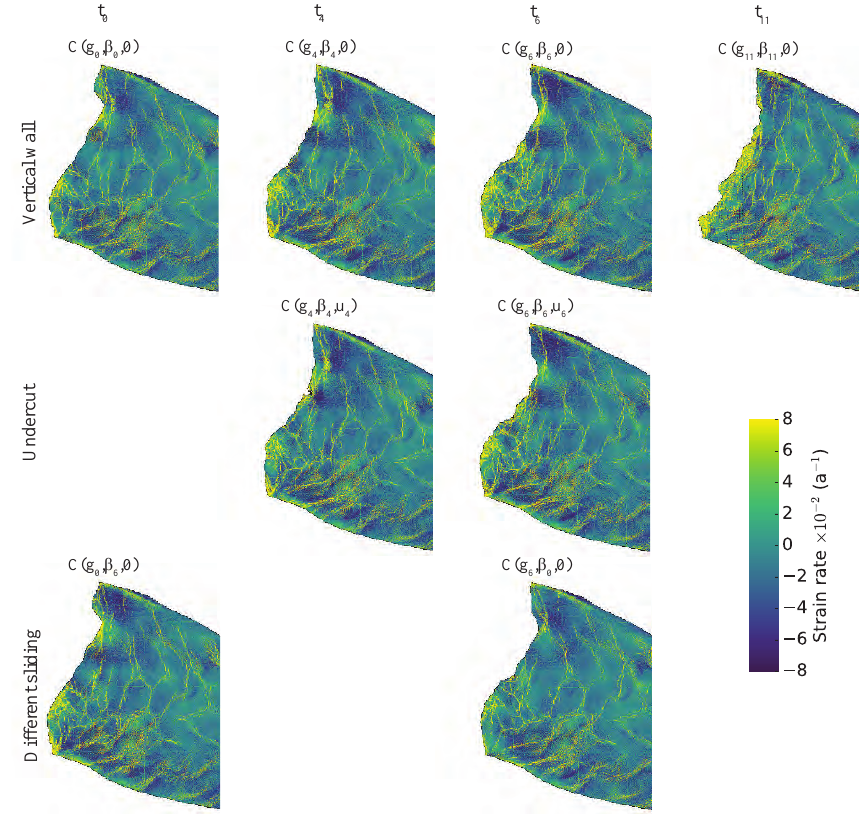
Figure 11. Strain rates modelled with HiDEM for each configuration. Yellow colouring shows the crevasse pattern and is denser close to the front where the difference between each configuration for the four selected iterations can be